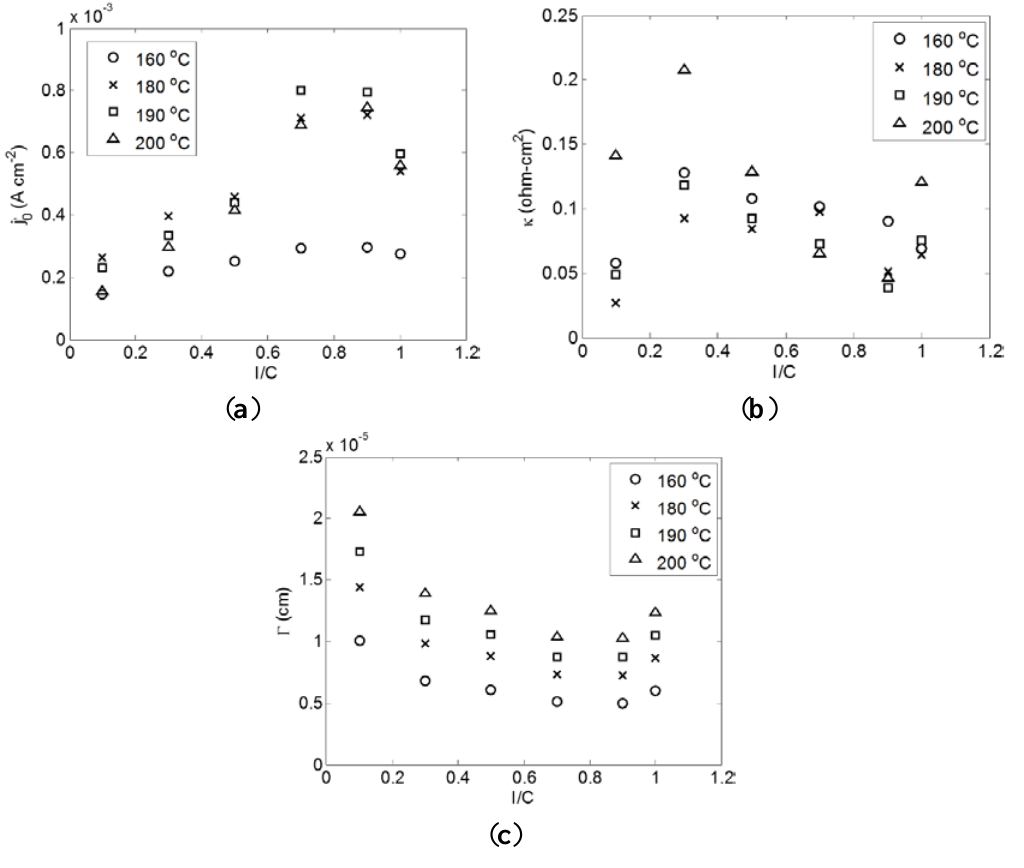
Figure 3. Correlation parameters as a function of I/C for different temperatures. Inset ( a ) represents the exchange current density parameter, resistance parameter, κ, and ( c ) represents the geometric parameter,